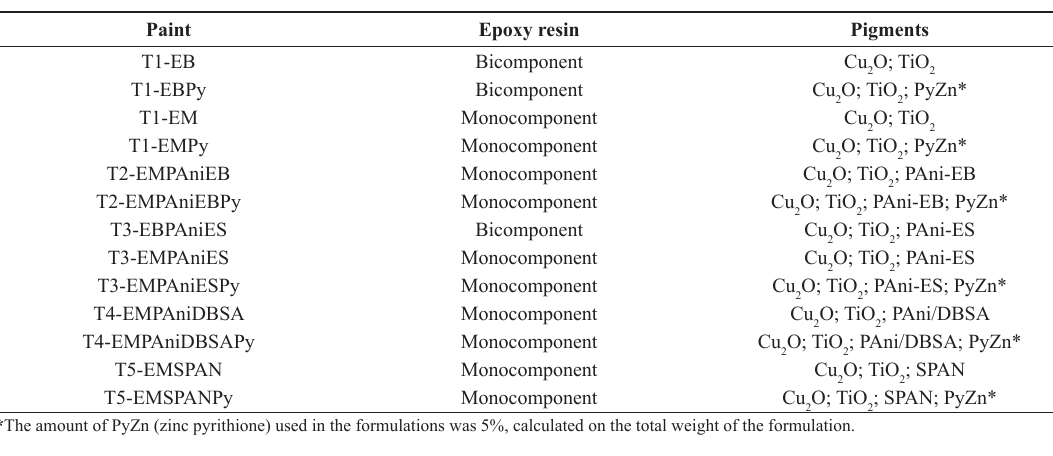
Table 2. Paints nomenclature obtained in the laboratory.